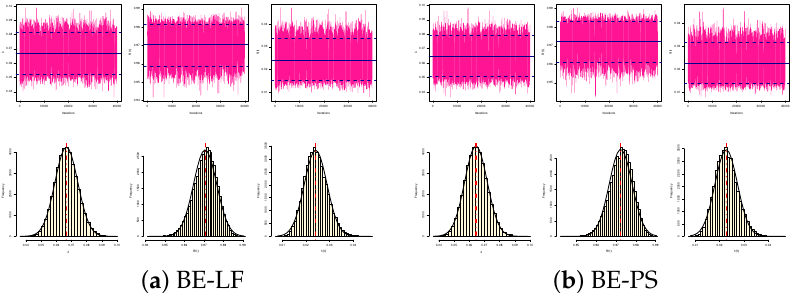
Figure 11. Trace ( top ) and histogram ( bottom ) plots of δ , R ( t ) and h ( t ) from MVAD